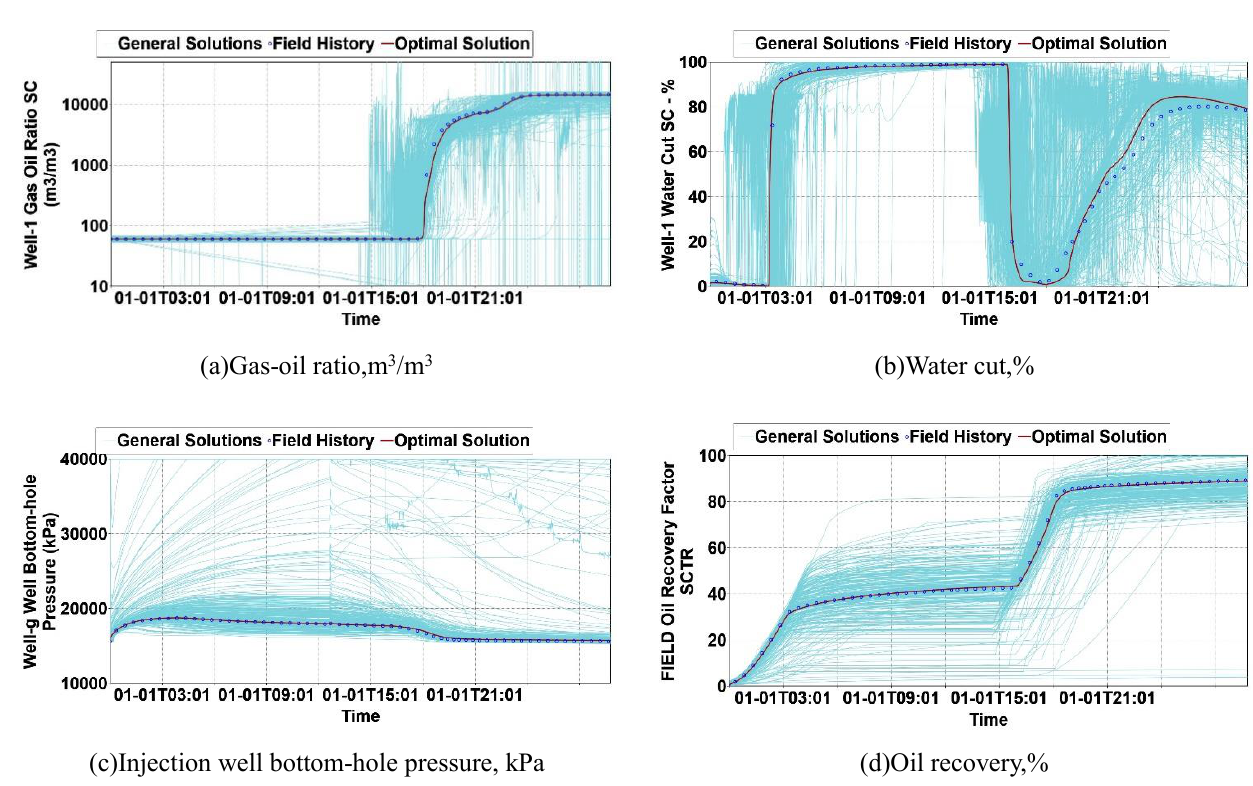
Figure 5—Fitting of data from the flooding experiment of the low-permeability